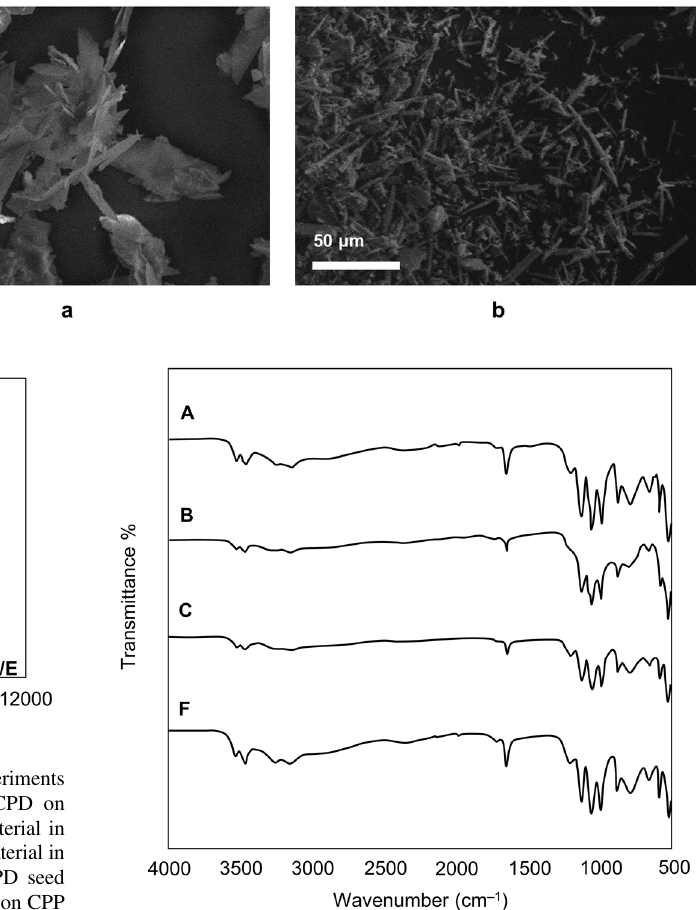
Fig. 6 FTIR spectra of samples prepared in experiments ( A ) growth of DCPD on DCPD seed material; B growth of DCPD on DCPD seed material in the presence of alanine; C growth of DCPD on DCPD seed material in the presence of glutamic acid and F: spontaneously grown DCPD (labile growth